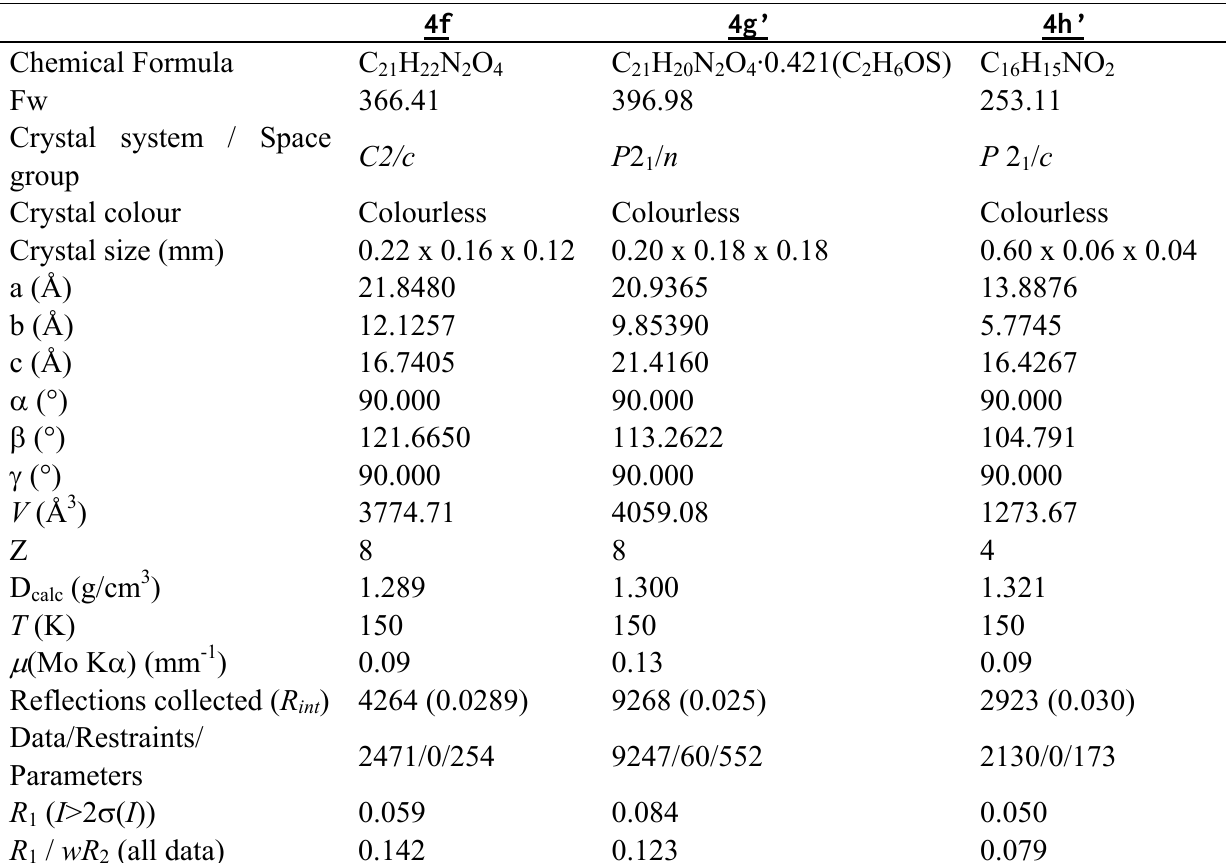
Table 3. Crystal data and structure refinements for compounds 4f , 4g’ and 4h